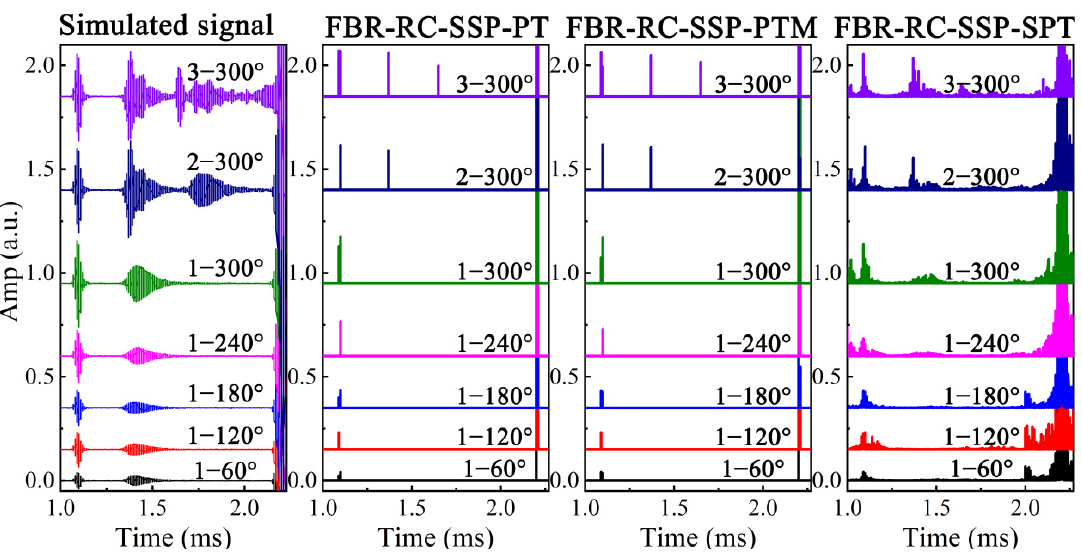
Figure 14. Simulated UGW signals before and after applying FBR-RC-SSP (1 ≤ defect number ≤ 3, 60° ≤ α ≤ 300°).